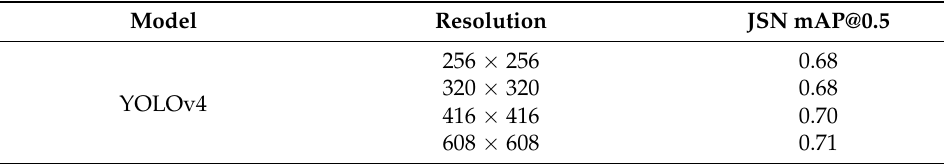
Table 4. Training results of step 2 (calculated by mAP@0.5).